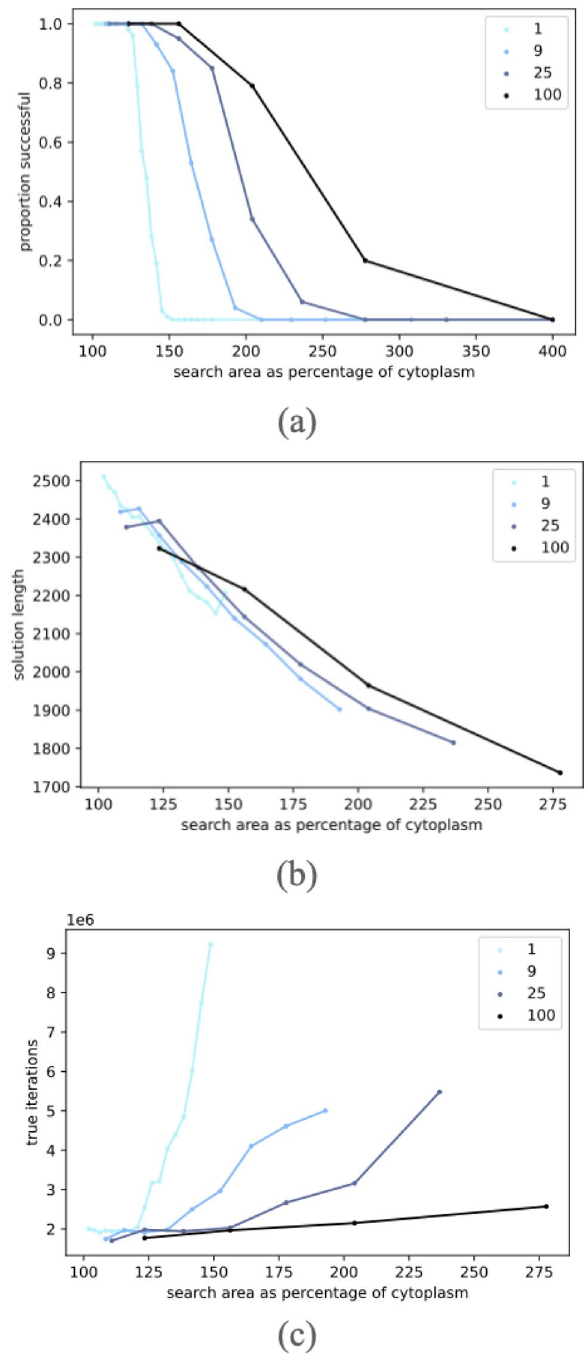
Figure 4. ( a ) Proportion of trials that are successful versus the search area as a percentage of cytoplasm for trials with 1, 9, 25, and 100 cells. ( b ) Length of solutions versus the search area as a percentage of cytoplasm. ( c ) Number of iterations versus the search area as a percentage of cytoplasm. Failed trails excluded from